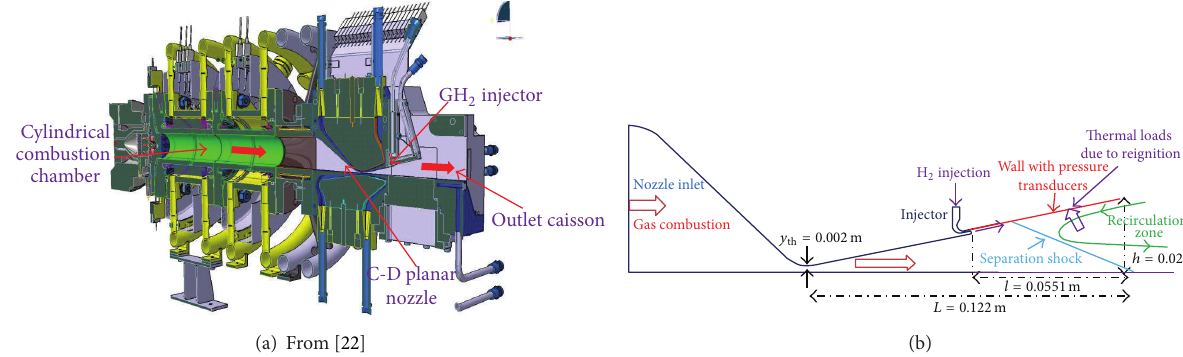
Figure 1: Mascotte test bench assembly (a) and sketch of longitudinal section of the planar nozzle (b).